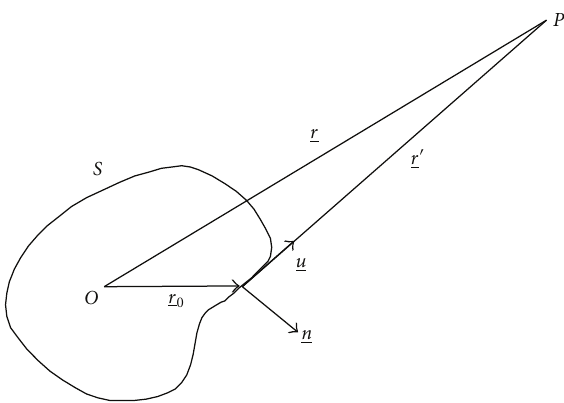
Figure 1: Geometry of Kirchho ff -Huygens formula, that is, (5), for the propagation of electromagnetic fields from Huygens surface S to point P